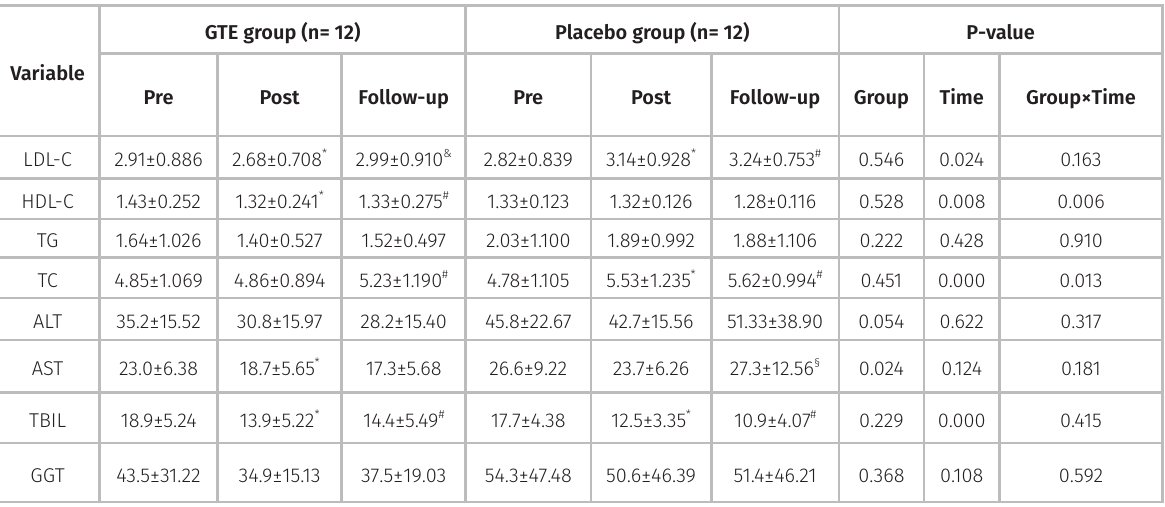
Table III. Biochemical analysis of the participants during the experimental and follow-up periods.